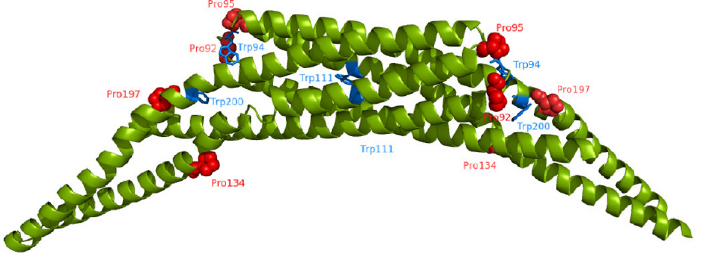
Fig 1. Structure of the human AmphiphysinII/Bin1 N-BAR domain. Ribbon representation of the quaternary structure of homodimeric N-BAR (PDB code: 2FIC). The three tryptophan residues per monomer are labeled in blue, the four proline residues per monomer in red spheres. The representation was prepared using PyMol.